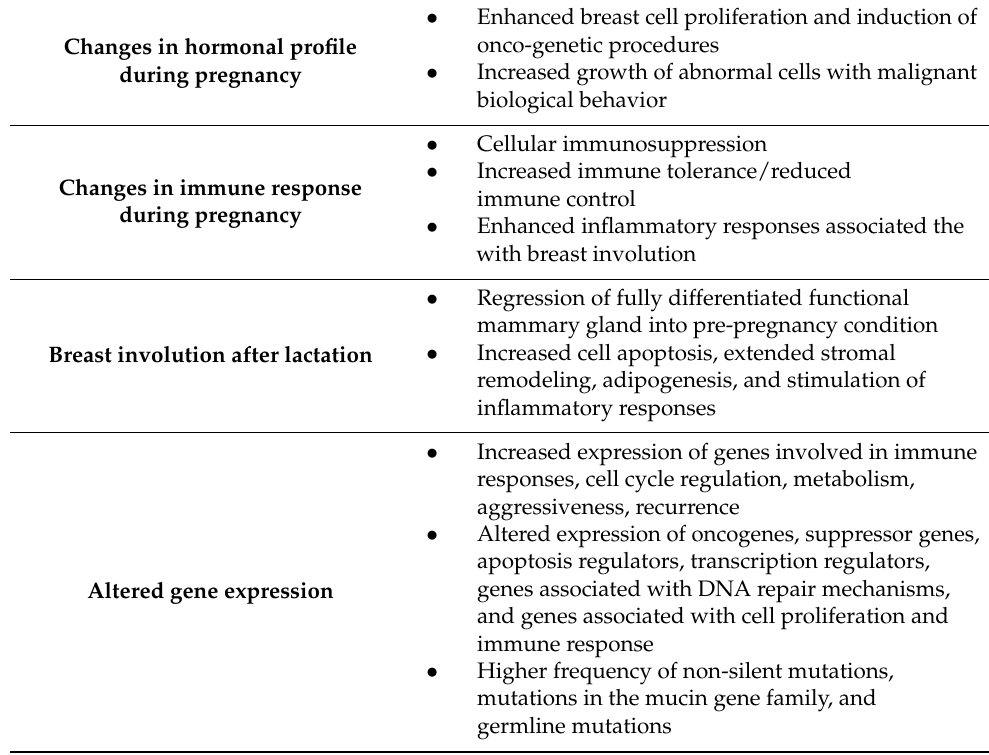
Table 2. Potential mechanisms involved in the pathogenesis of pregnancy-associated breast